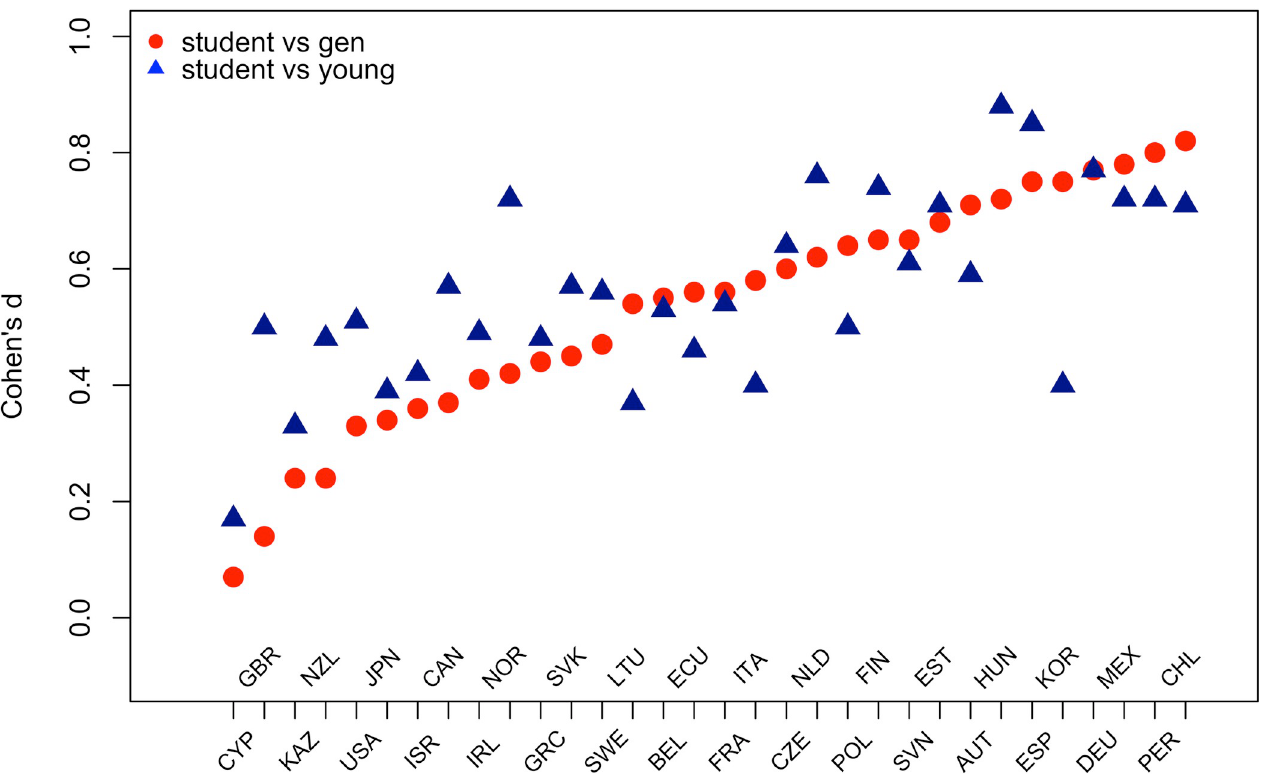
Fig 3. Effect size comparisons in literacy scores between the Student and General samples and the Student and Young by country. Red dots represent effect size comparison of Student vs General samples and blue triangles represent effect size comparison for Student vs Young samples.